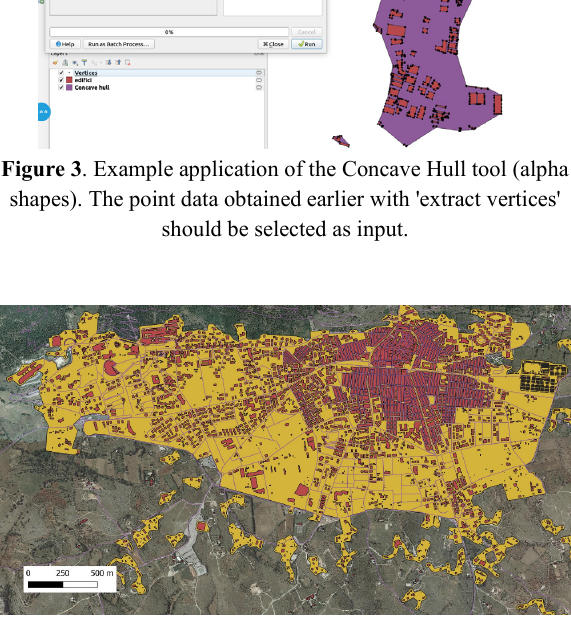
Figure 4 . Example of identification and perimeter of urban aggregations (ochre color) with built-up area overlay (red color).